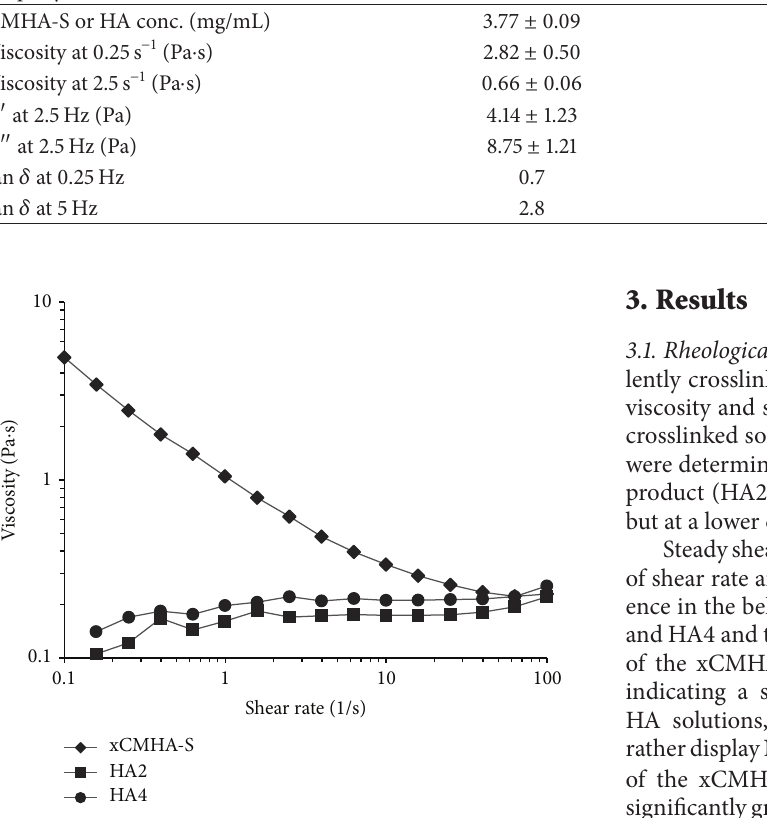
Table 2: Properties of the three materials tested in this study. The concentration of CMHA-S or HA was determined using a carbazole assay (𝑛 = 6) . Viscosity and shear moduli are averages of 8 samples. Property